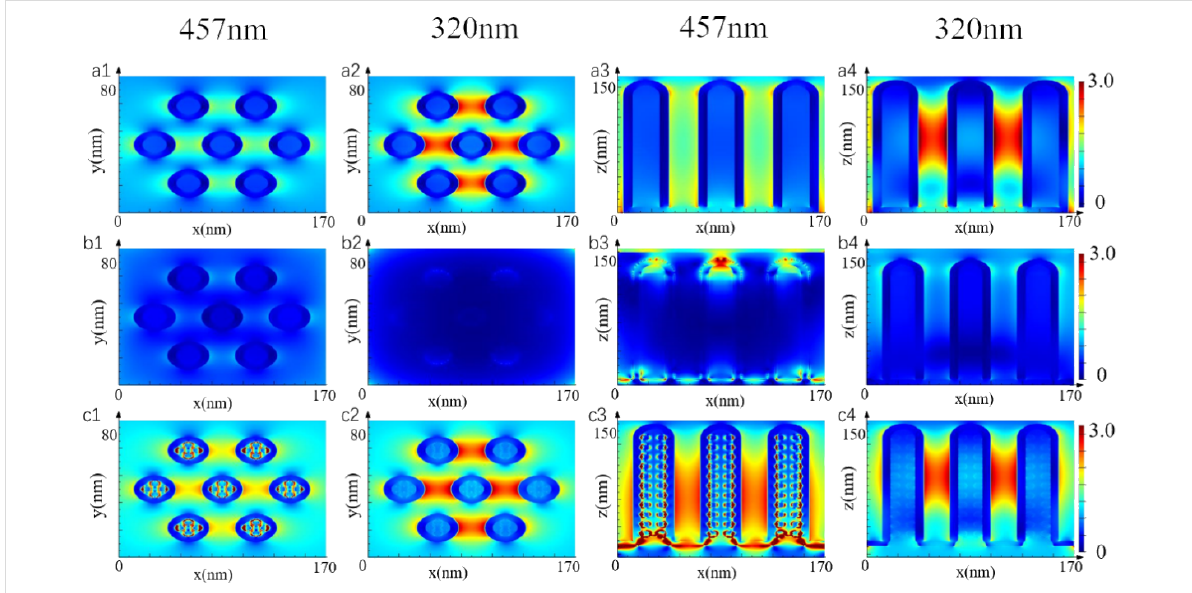
Figure 8: FDTD simulations of the electric field distribution of Ag-loaded TiO 2 nanocolumns with different structures. a1) Wavelength 457 nm TNC cross section, a2) wavelength 320 nm TNC cross section, a3) wavelength 457 nm TNC longitudinal section, a4) wavelength 320 nm TNC longitudinal section, b1) wavelength 457 nm ACT3 cross section, b2) wavelength 320 nm ACT3 cross section, b3) wavelength 457 nm ACT3 longitudinal section, b4) wavelength 320 nm ACT3 longitudinal section, c1) wavelength 457 nm AFT3 cross section, c2) wavelength 320 nm AFT3 cross section, c3) wave- length 457 nm AFT3 longitudinal section, c4) wavelength 320 nm AFT3 longitudinal section.